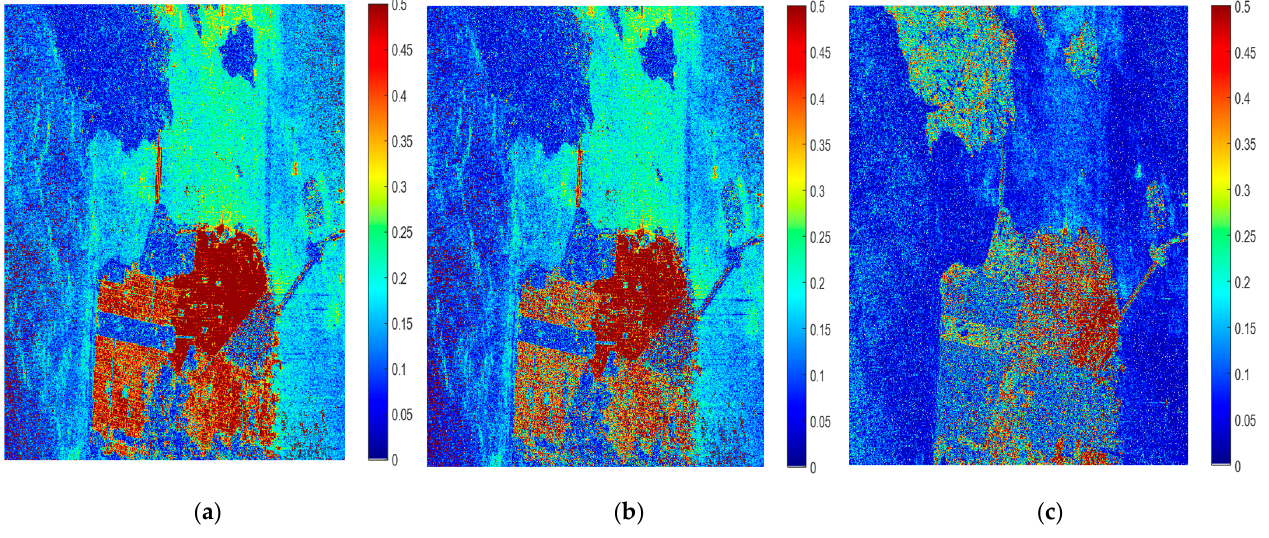
(cid:68) (cid:69) 2 S . ( a ) Souyris’ model. ( b ) Nord’s model. ( c ) Proposed | S HV | 2 . ( a ) Souyris’ model. ( b ) Nord’s model. ( c ) Proposed HV